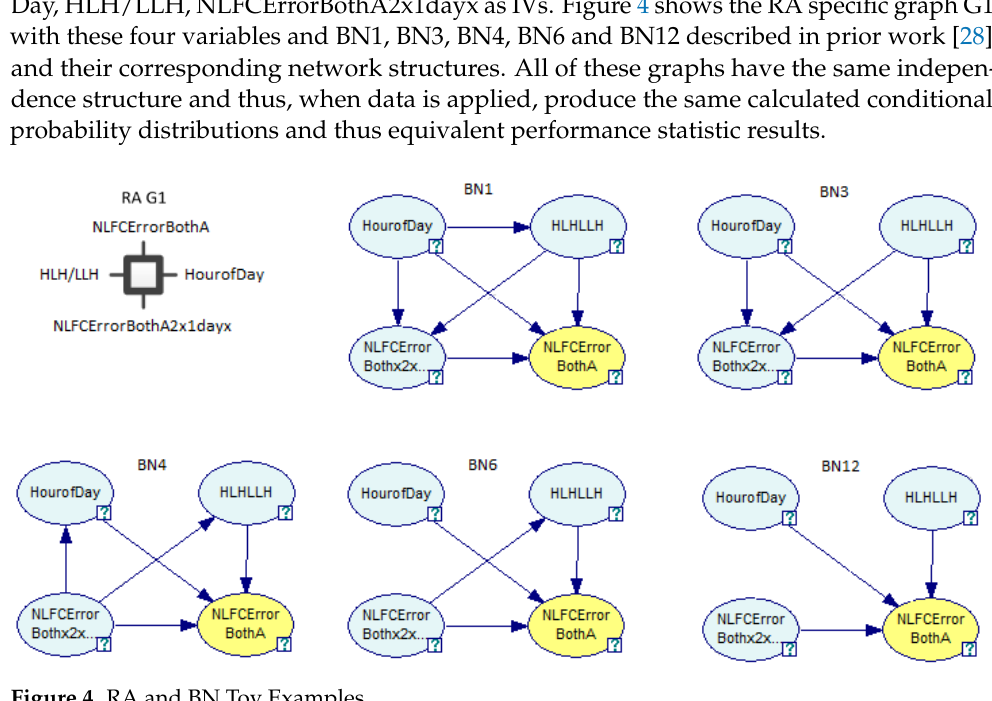
Figure 4. RA and BN Toy Examples.